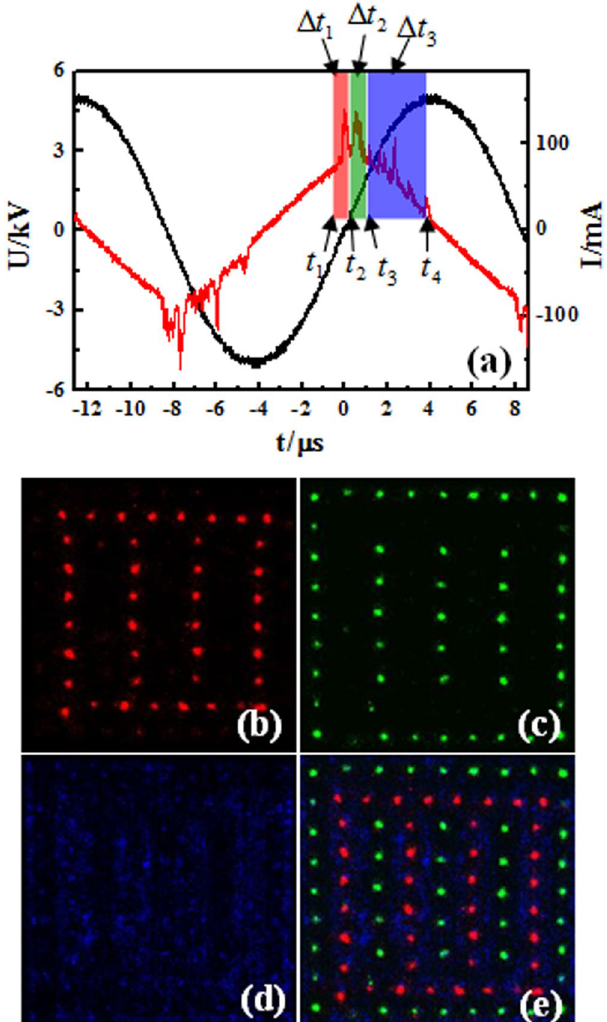
Figure 2. Instantaneous images of the complex pattern with hexagonal lattice and white-eye stripe. ( a ) Waveforms of the applied voltage and current of the pattern. ( b ) Big spots. ( c ) Small spots. ( d ) Halos. The pictures ( b – d ) are, respectively, correlated with current pulse phases ( Δ t 1 = 500 ns, = 400 ns, and = 1900 ns) in ( a ) and integrated over 100 voltage cycles to obtain sufficient light signals. ( e ) The frame is the superposition of ( b , c and d